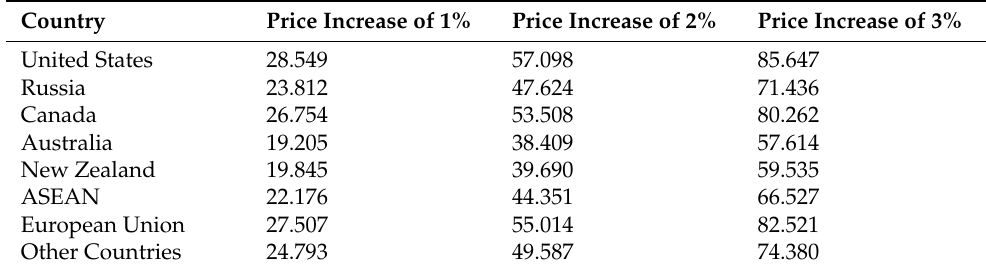
Table 8. Impact of price changes on the import volume of the main source countries of agricultural products.